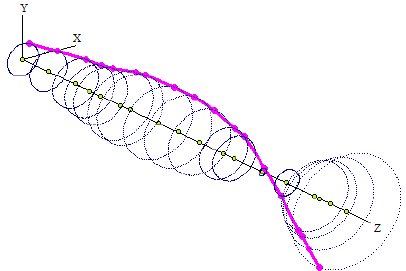
Figure 21. Vibration modes with large unbalance due to blade off at the first stage axial compressor.